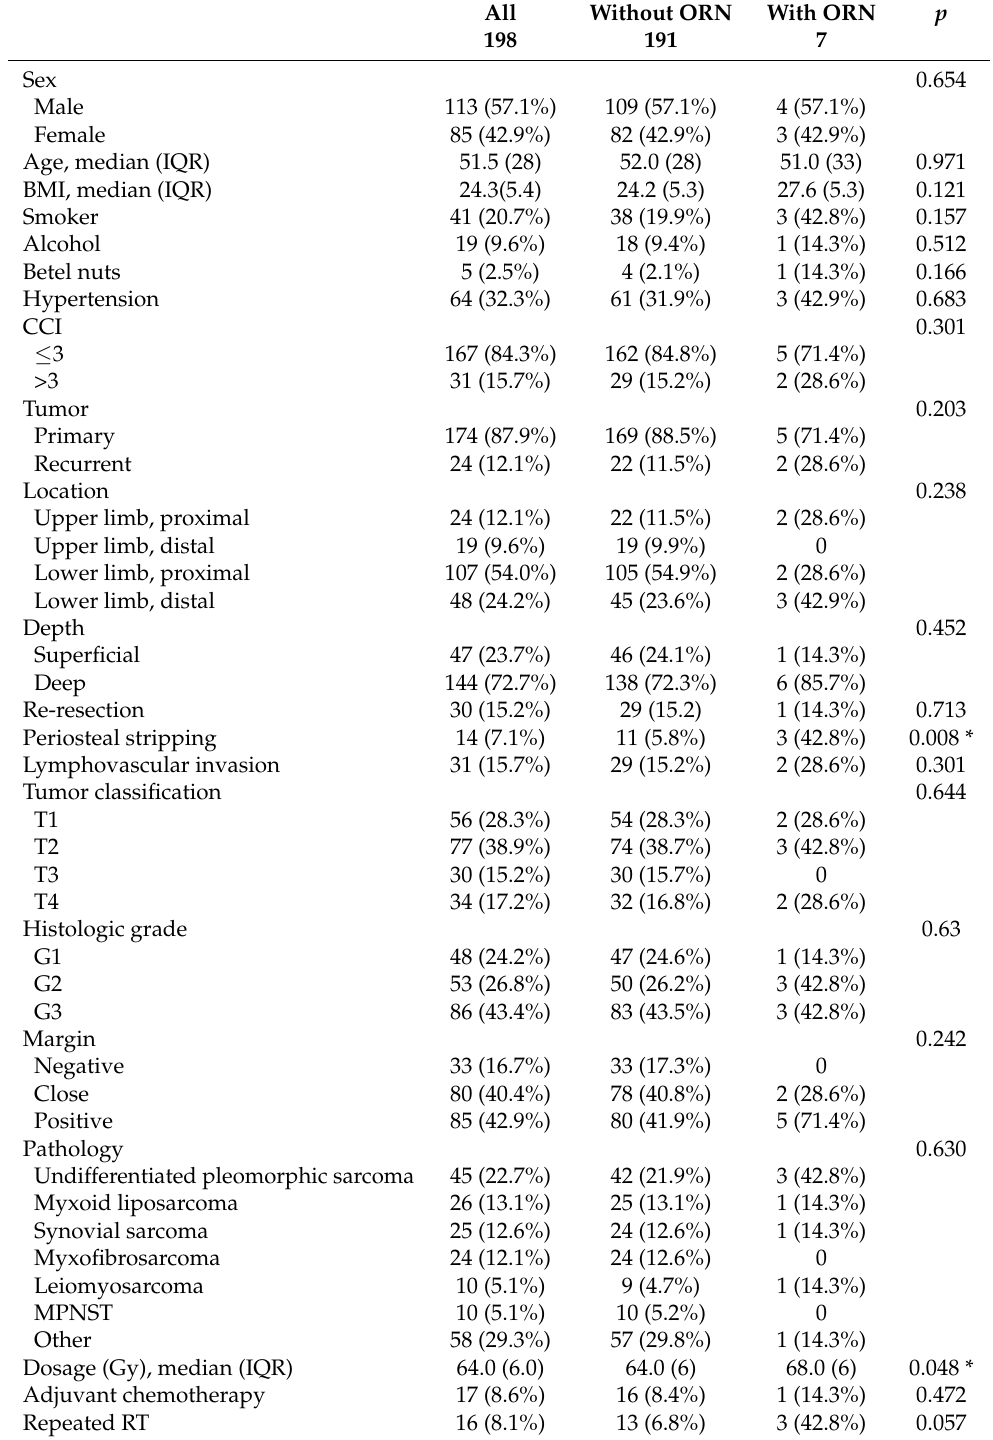
Table 1. Patient